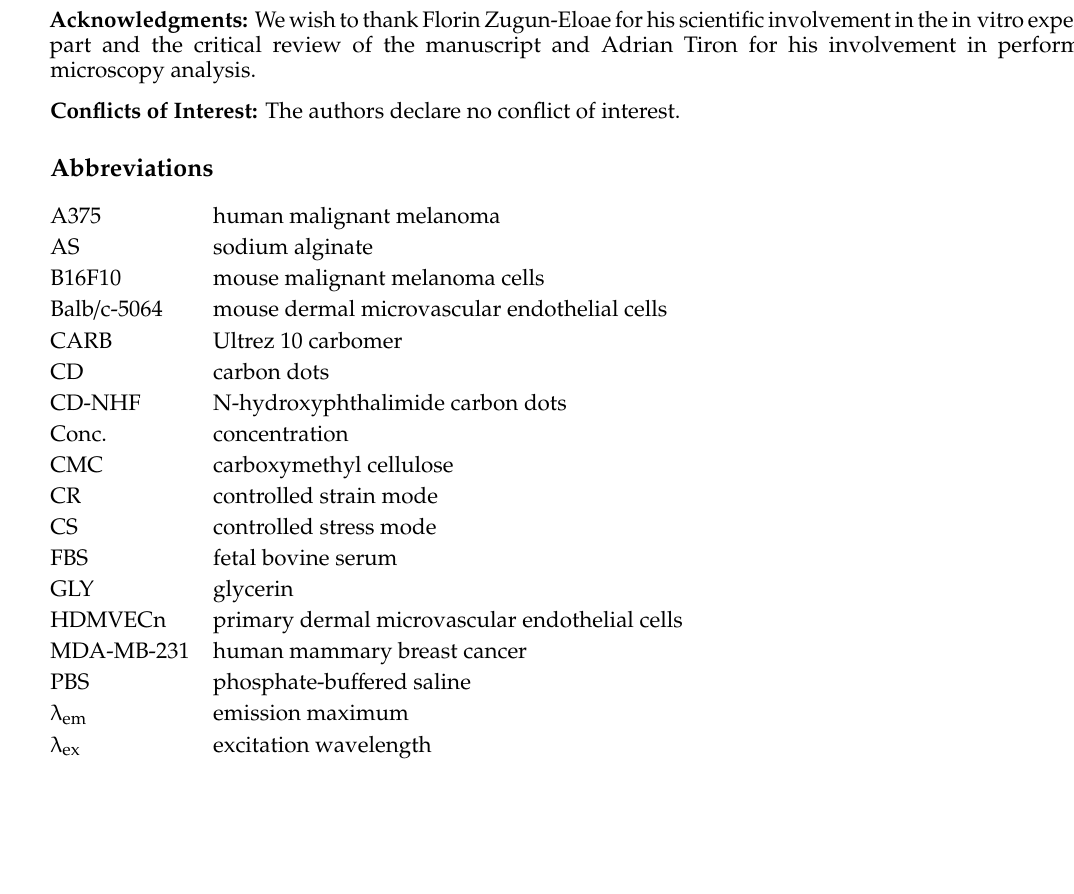
Figure S1. Experimental setup used to prepare carbon dots. Figure S2. FT-IR spectra for CD-NHF. Figure S3. Photos of gels without and with CD-NHF under (a) white and (b) UV light. Figure S4. Spheroid fluorescent staining using green / FITC (left column) for live cells, blue / NucBlue for nuclei (middle column), and merged signals (right column) from 3D human melanoma cell cultures. Figure S5. The analytical segmentation procedure for a typical spheroid image. Table S1. Fluorescence results obtained for CD-NHF-loaded gels at di ff erent excitation wavelengths: 370–410